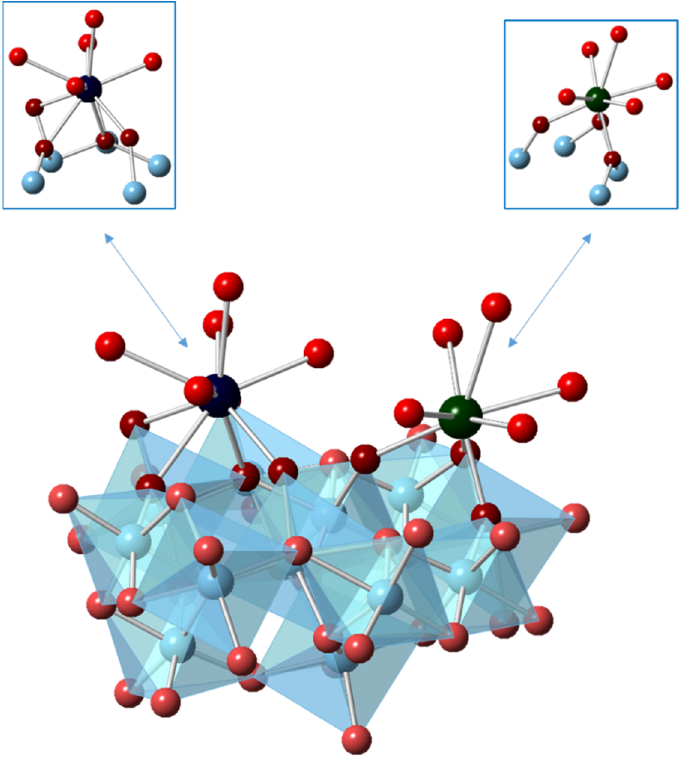
Figure 2. The optimized Am 3+ complexes on the corundum (110) surface. ( Left ) tetradentate complex at a low surface loading with an overall coordination number of 9. ( Right ) tridentate complex at a high surface loading with an overall coordination number of 8. Hydrogen atoms have been omitted from the figure for the sake of clarity. Framed figures show the Am 3+ complexes with the coordinating oxygen atoms and the underlying aluminum cations only. Al = light blue, Am (tetradentate) = dark blue, Am (tridentate) = green, O (Am hydration sphere) = red, O (coordinating surface oxygens) = dark red, O (others) = light red.